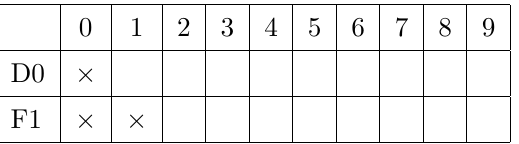
Table 5 . 1 -BPS brane intersection underlying the AdS 2 (cid:2) S 7 (cid:2) I (cid:11) solution. This brane setup is a 4 particular example in the class of